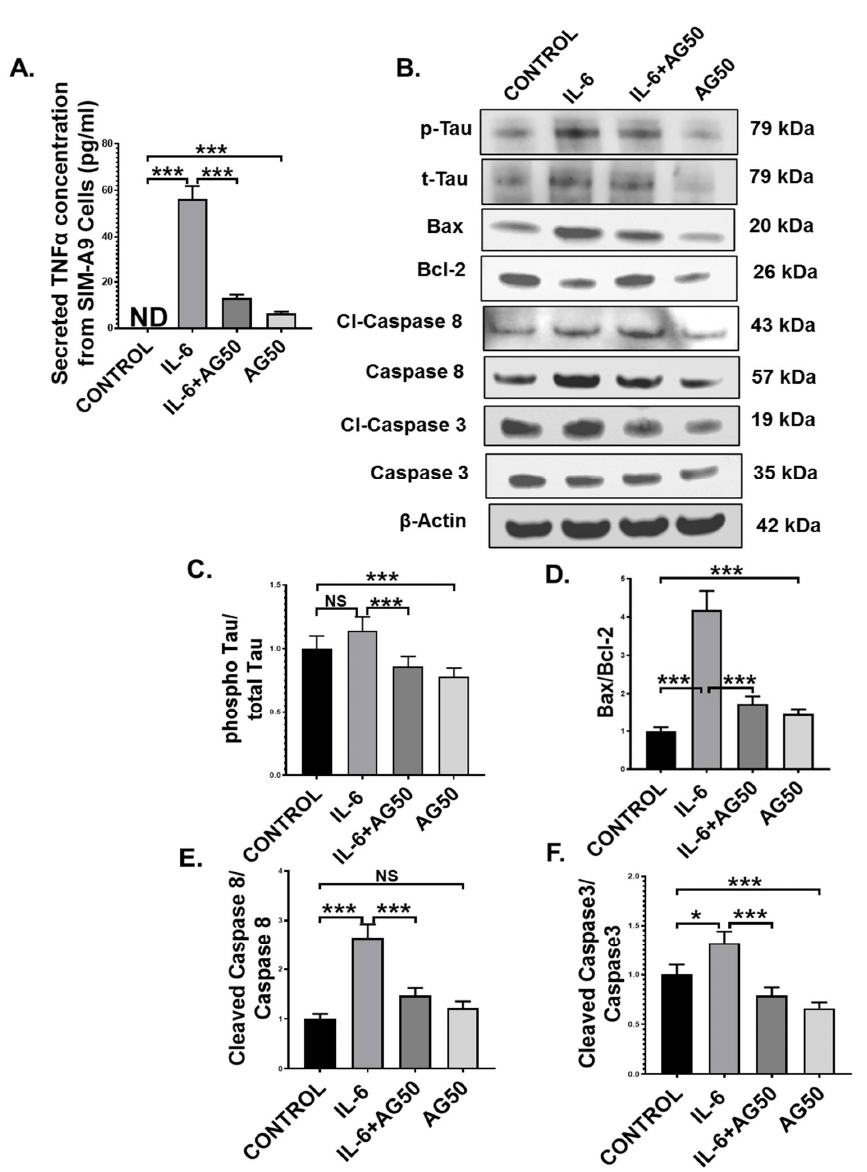
Figure 10. AG treatment decreased TNFα release from IL-6 primed SIM-A9 mouse microglial cells and MCM-induced extrinsic apoptosis, and tau phosphorylation in Neuro-2a mouse neuroblastoma cells. ( A ) The concentration (pg/mL) of TNFα level secreted from SIM-A9 cells treated with vehicle only (CONTROL), IL-6 only (IL-6), a combination of IL-6 and AG 50 µM (IL-6+AG50), and AG 50 µM only (AG50) as detected by ELISA using cell supernatants (ND = Not detected). Neuro-2a cells were treated with MCM collected from SIM-A9 cells, which were treated previously with vehicle only (CONTROL), IL-6 only (IL-6), a combination of IL-6 and AG 50 µM (IL-6+AG50), and AG 50 µM only (AG50). ( B ) Western blot images of p-Tau, t-Tau, BAX, Bcl-2, Cl-Caspase 8, Caspase 8, Cl-Caspase 3, Caspase 3 protein expression level obtained from Neuro-2a cell lysates. Lanes 1–4 represent CONTROL, IL-6, IL-6+AG50, and AG50 groups, respectively. Densitometry analyses of ( C ) phospho-Tau immunoblot normalized against total-Tau, ( D ) BAX immunoblot normalized against Bcl-2, ( E ) Cleaved Caspase 8 immunoblot normalized against Total Caspase 8 immunoblot, and ( F ) Cleaved Caspase 3 immunoblot normalized against Total Caspase 3 immunoblot (* p < 0.05, *** p < 0.001, NS: non-significant). Data were represented as mean ± SEM and statistical significance was tested using unpaired t -test between the groups (* p < 0.05, ** p < 0.01, *** p < 0.001), followed by Bonferroni Dunn Post hoc